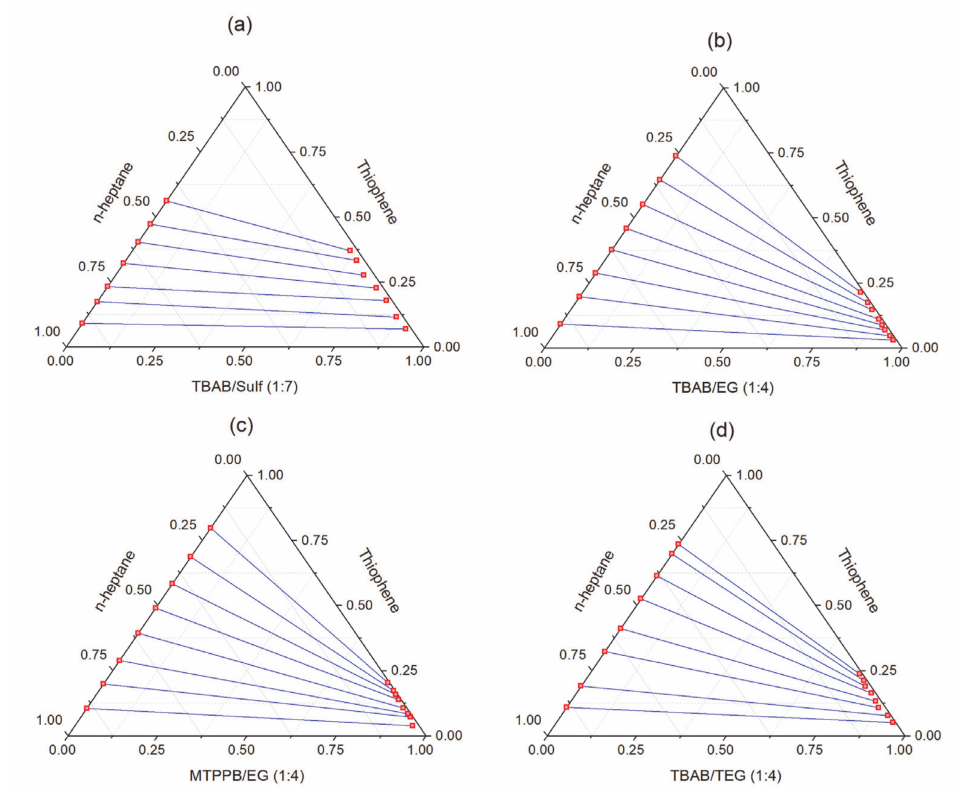
Figure 12. Experimental tie-lines for the ternary systems ( a ) thiophene + n -heptane + TBAB/Sulf (1:7), ( b ) thiophene + n -heptane + TBAB/EG (1:4), ( c ) thiophene + n -heptane + MTPPB/EG (1:4), and ( d ) thiophene + n -heptane + TBAB/TEG (1:4) at T = 298.15 K and 0.1 MPa. Data are taken from [143].